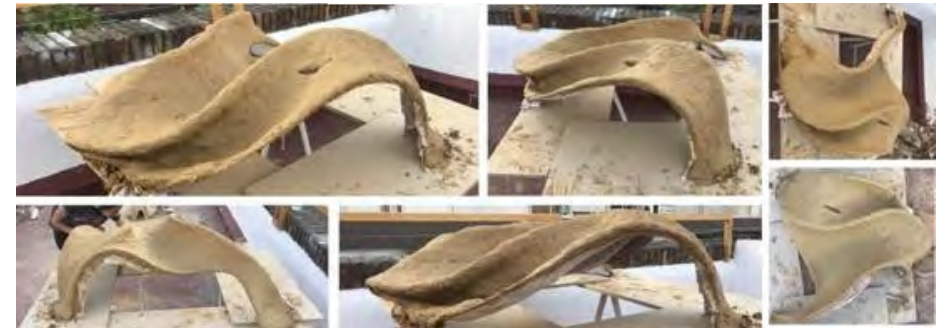
Figure 12. Failed experiment of ashell collapsed when applying different layers of clay mix, because the initial geometry was not matching the viable